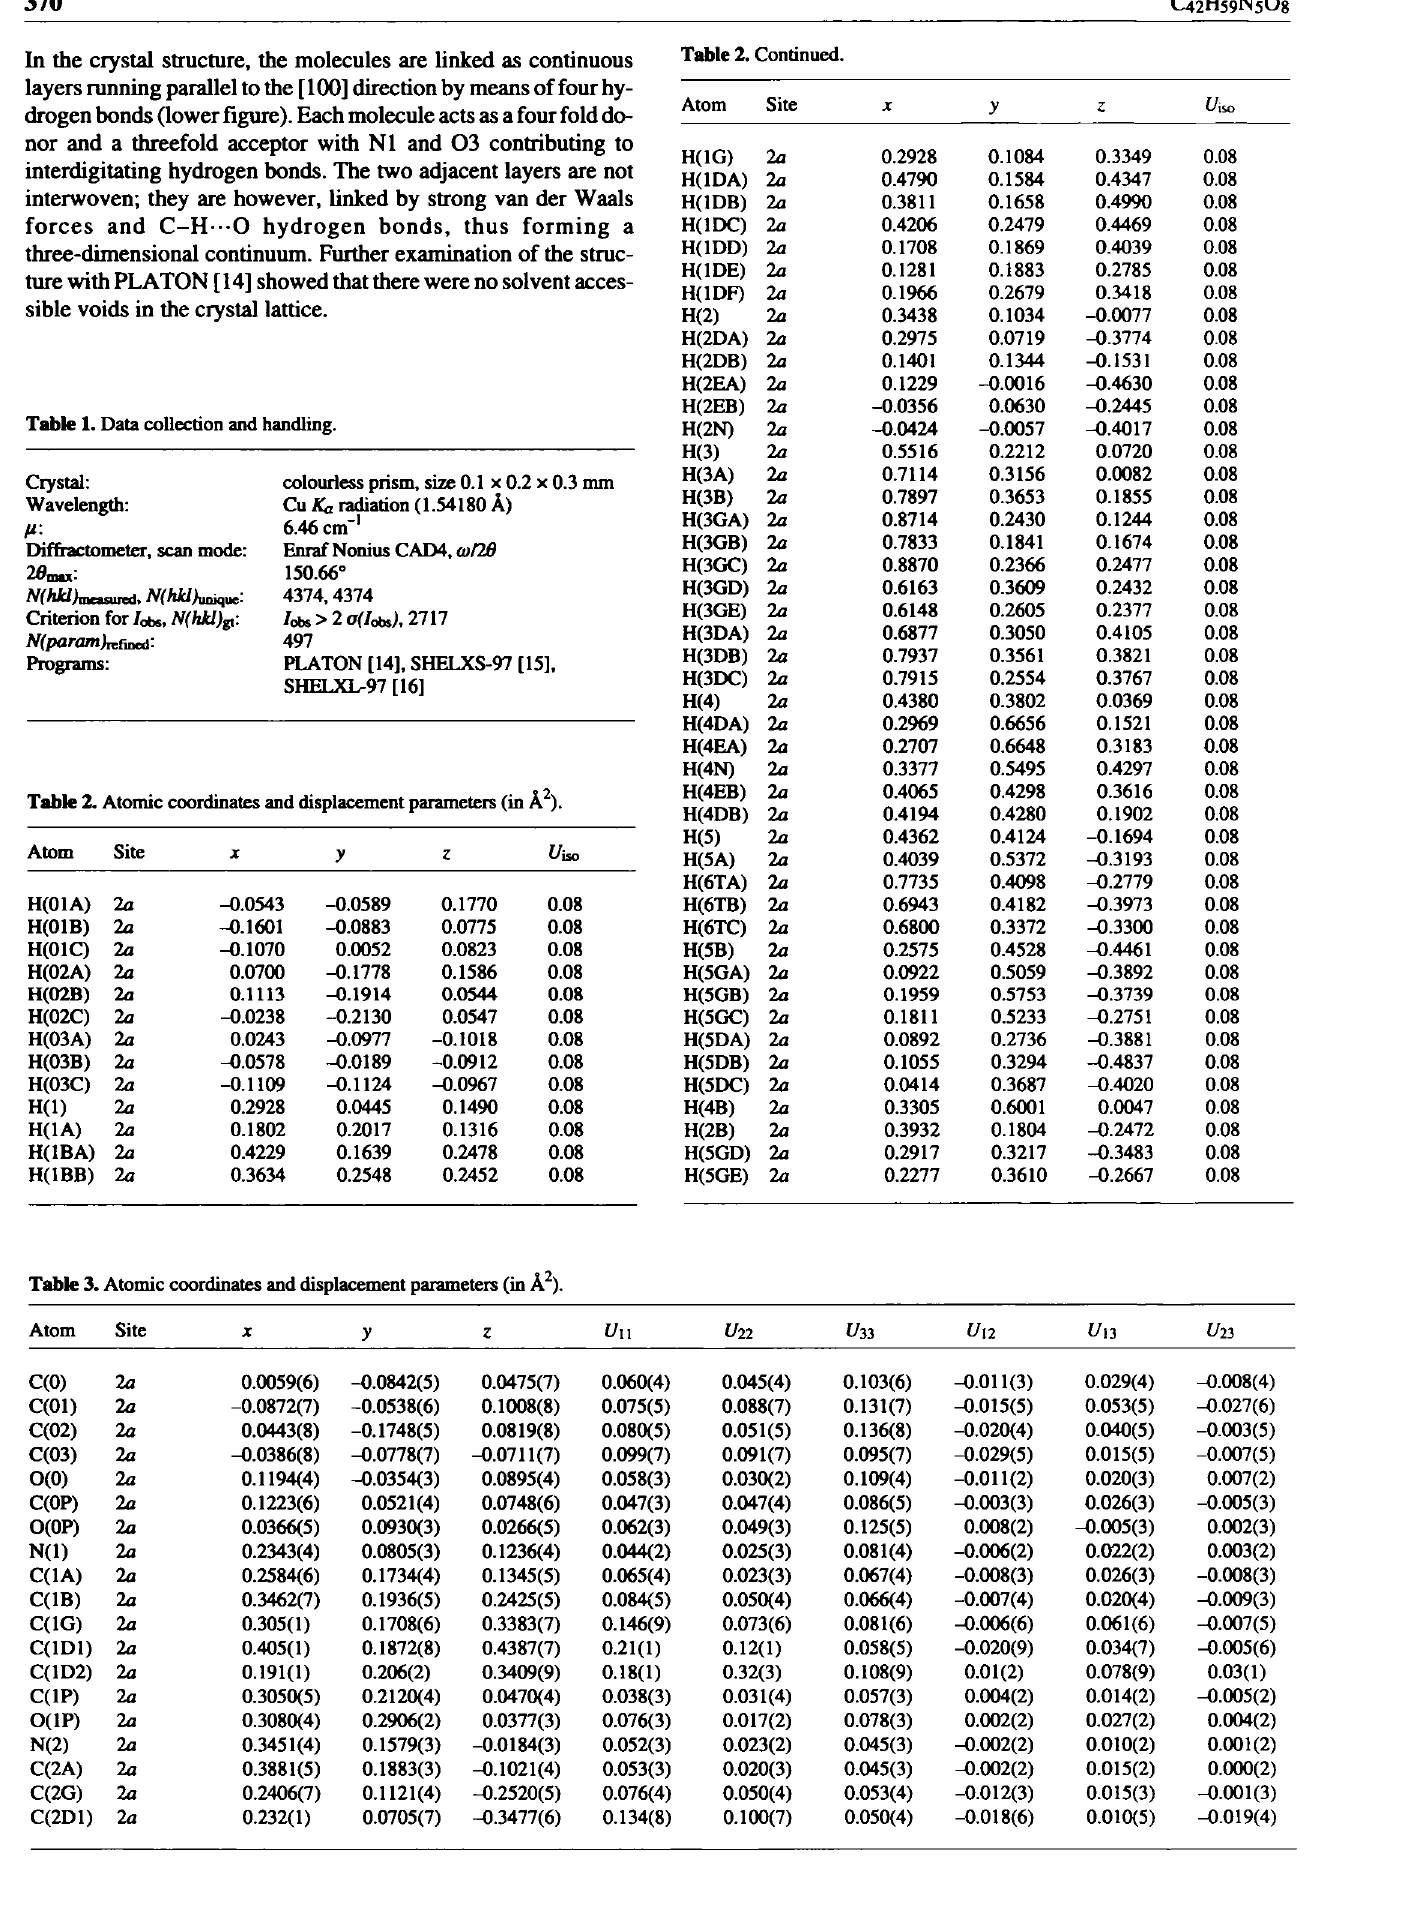
Table 3. Atomic coordinates and displacement parameters (in Â 2